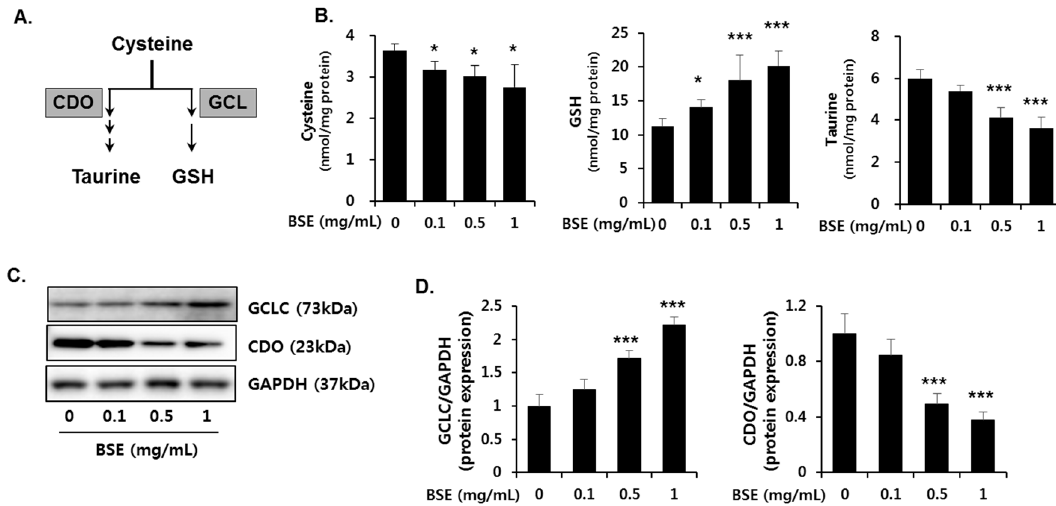
Figure 8. Effect of barley sprout extract (BSE) on the de novo synthesis of GSH and taurine in HepG2 cells. ( A ) Synthesis of taurine and GSH from cysteine in the liver. Cells were exposed to indicate concentrations of BSE for 18 h and ( B ) the cellular concentration of metabolites including cysteine, GSH, and taurine were determined using HPLC; ( C ) protein expression of GCLC, CDO, and GAPDH in the whole-cell lysate and ( D ) quantitative analysis of the blots normalized by GAPDH expression. Each value represents the mean ± SD. *, *** Significantly from vehicle-treated control cells at p < 0.05 and 0.001, respectively (Student’s t -test).